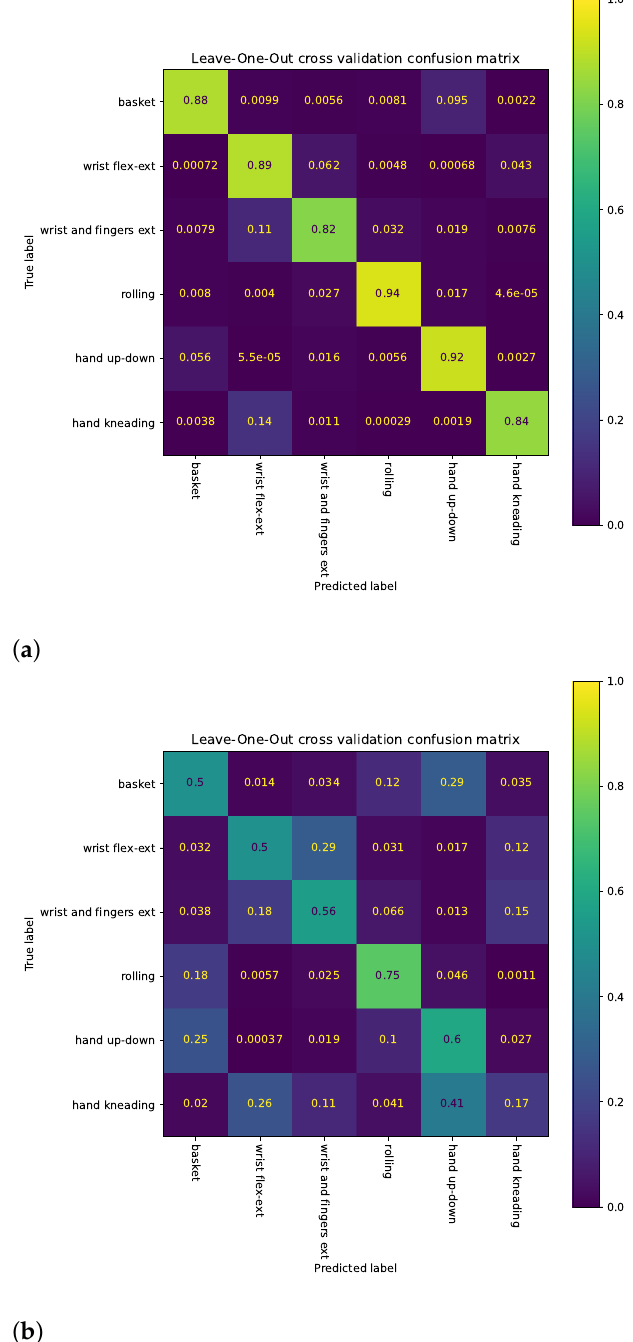
Figure 14. Confusion matrices for classification task (normalized by category cardinality). ( a ) Con- fusion matrix from five-fold cross validation. ( b ) Confusion matrix from leave-one-subject-out cross